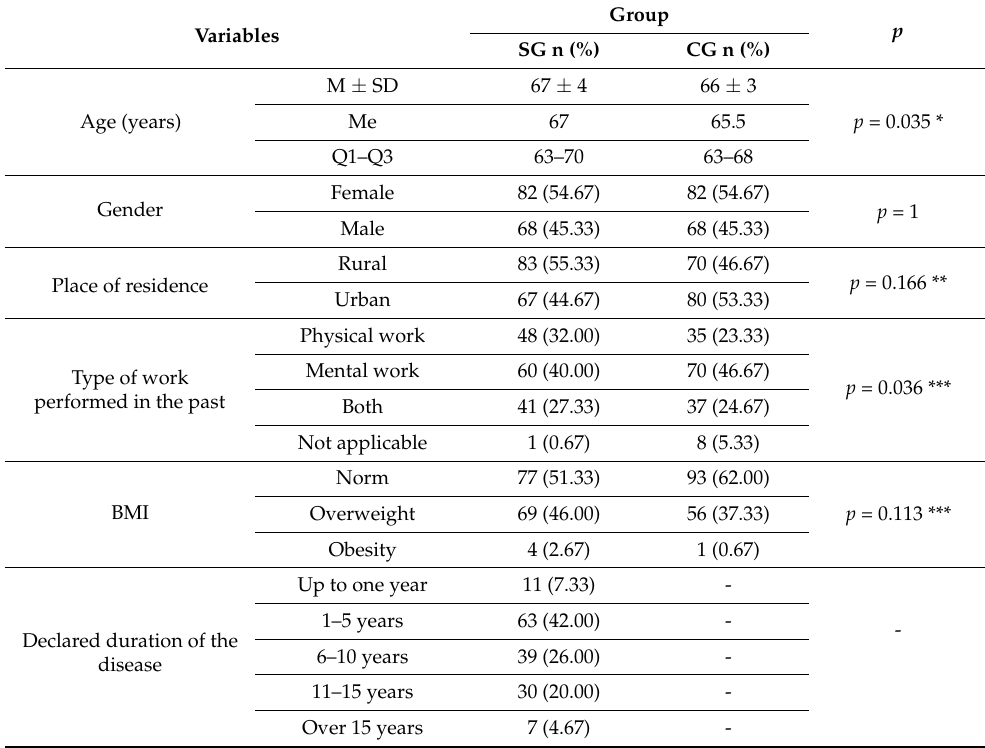
Table 2. Comparison of the study participants in terms of gender, age, place of residence and type of job performed in the past and